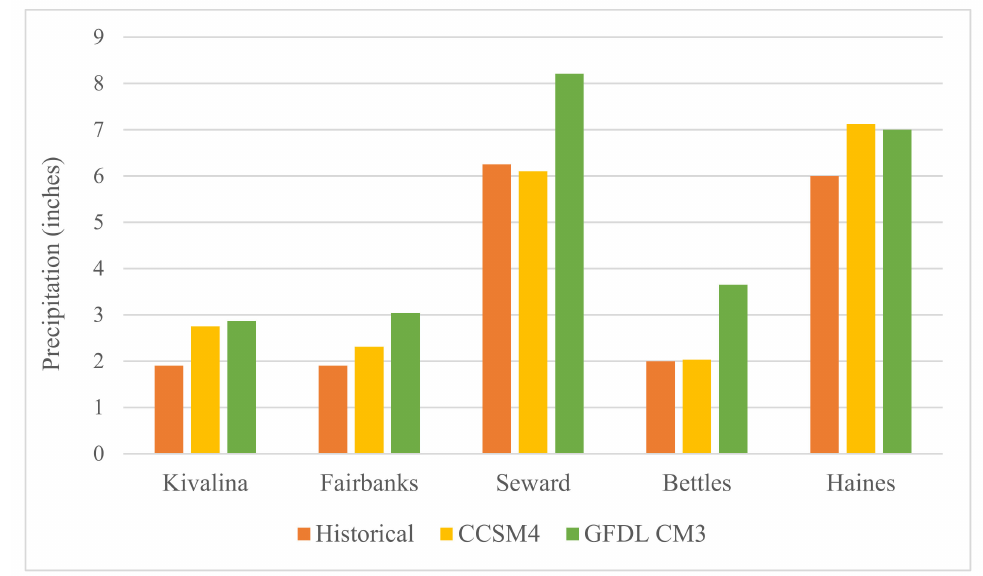
Figure 8. 3 day precipitation amounts having a return interval of five